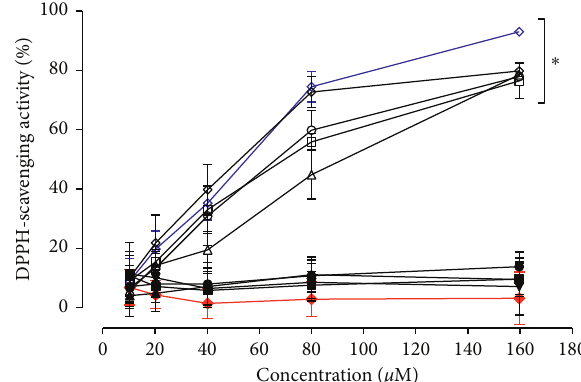
Figure 2: DPPH radical-scavenging activity of 4a ( ● ), 4b ( ■ ), 4c ( ▲ ), 4d ( ▼ ), 5a ( ◇ ), 5b ( ○ ), 5c ( □ ), 5d ( △ ), piperine ( ◆ ), and VC ( ◆ ). ∗ indicates a significant difference from the piperine group ( p < 0 . 05).